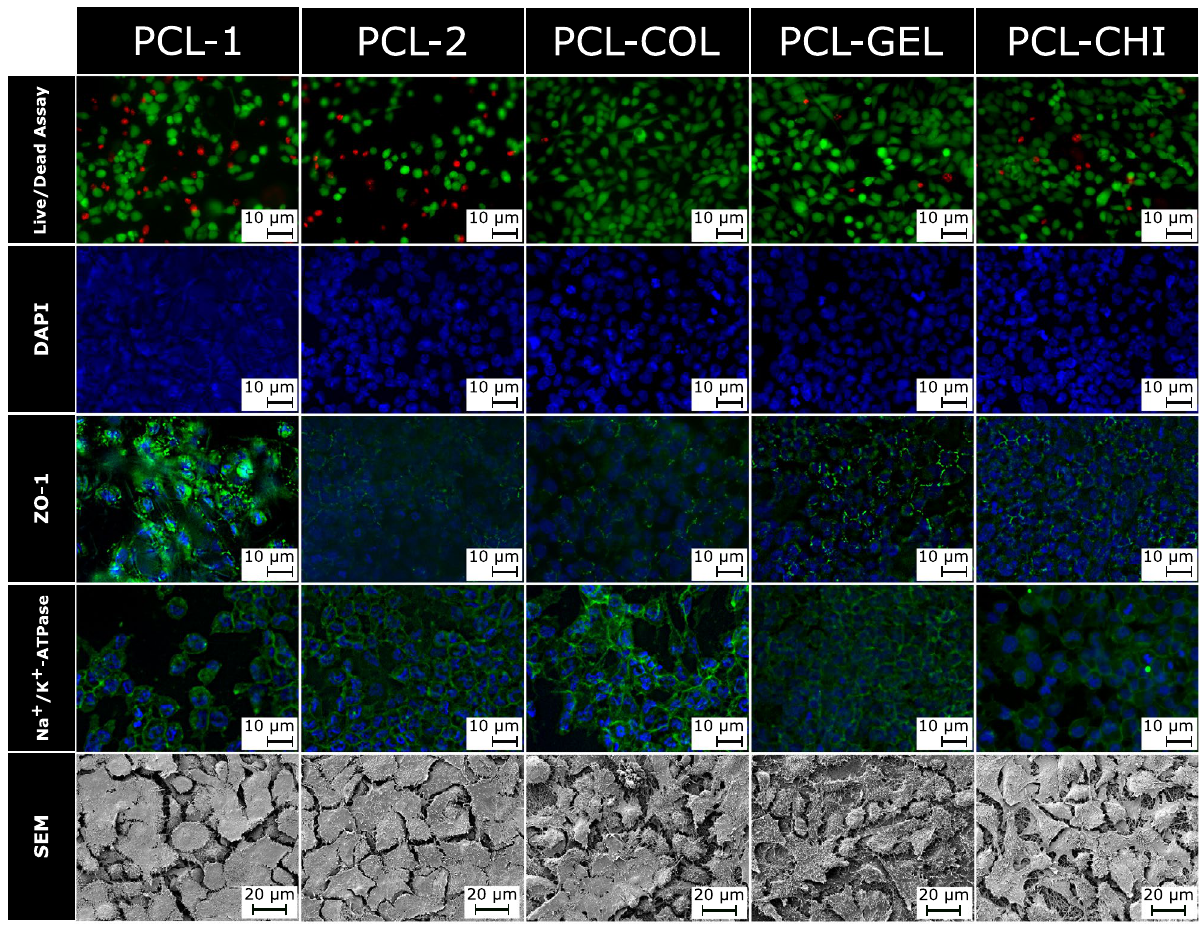
Figure 5. Staining of human corneal endothelial cells (HECEs) with fluorescein diacetate (FDA) and propidium iodide (PI) (top row) allows the distinction between live and dead cells. PCL-COL and PCL-GEL have a significantly higher cell viability ( p < 0,001) compared to pure PCL scaffolds. Immunofluorescence staining with the antibodies ZO-1 (third row) and Na + /K + -ATPase (forth row) are indicators for working cell functions. SEM images (bottom row) indicate cell monolayers for all samples.